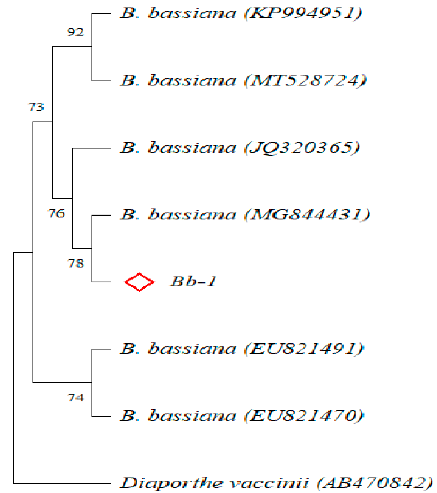
Figure 1. Construction of phylogenetic tree (Neighbour-Joining method; ♦ represent one B. bassiana strain isolated in this study; AB470842 Diaporthe vaccinii as outgroup).